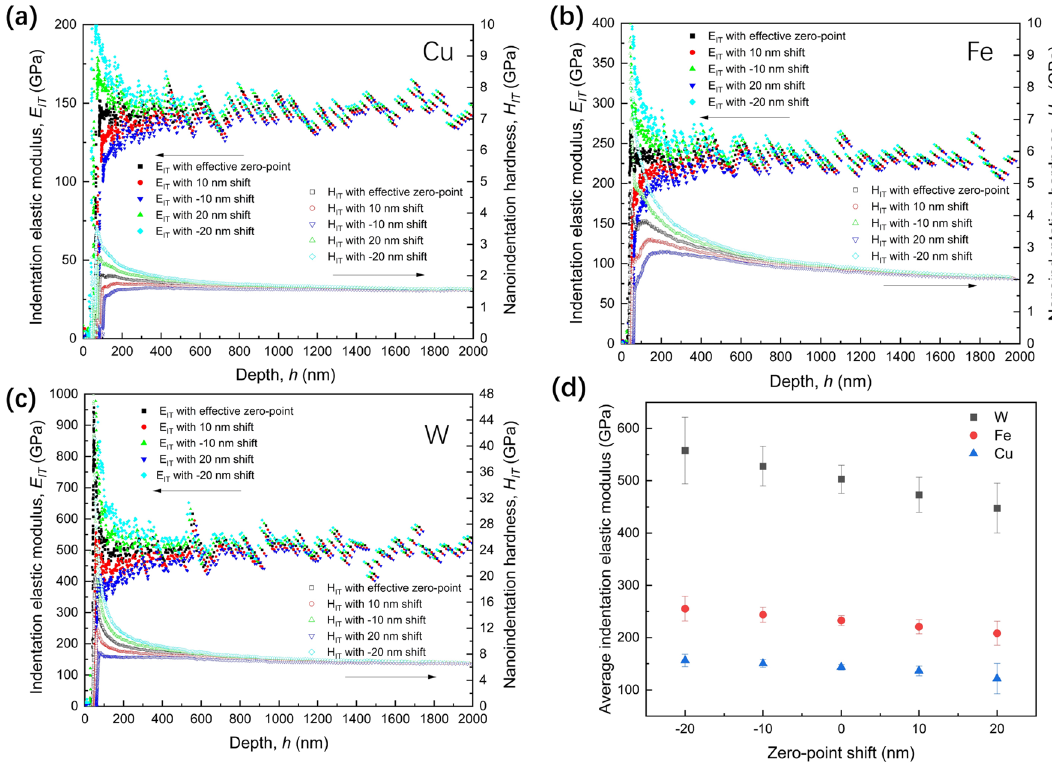
Figure 3. Impact of the zero-point shift on indentation elastic modulus and nanoindentation hardness on pure metals Cu, Fe, and W. ( a ) Indentation elastic modulus and nanoindentation hardness after zero-point shift on Cu. ( b ) Indentation elastic modulus and nanoindentation hardness after zero-point shift on Fe. ( c ) Indentation elastic modulus and nanoindentation hardness after zero-point shift on W. ( d ) Average and standard deviation of indentation elastic modulus after zero-point shift on Cu, Fe, and